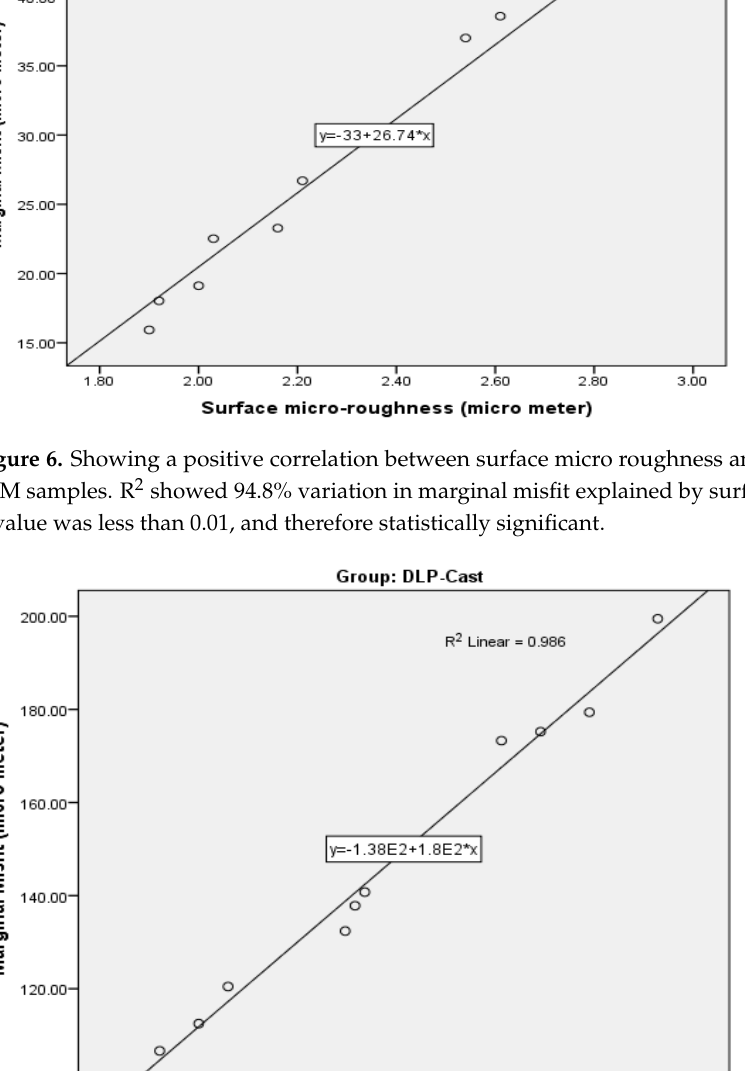
Figure 7. Showing a positive correlation between surface micro roughness and marginal misfit in DLP Cast samples. R 2 showed 98.6% variation in marginal misfit explained by surface micro roughness; p -value was less than 0.01, and therefore statistically significant.